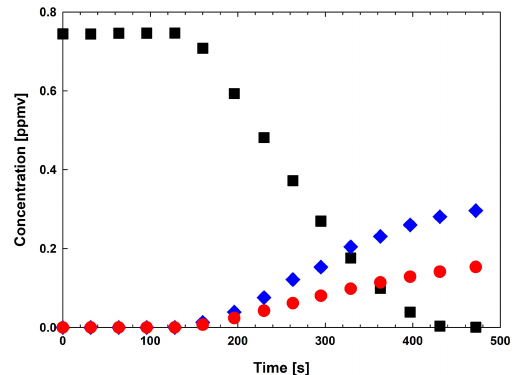
Figure 6. Concentration–time profiles for the reaction of MMPO ( ) + OH radicals and the quantified product of methyl formate ( MF) and peroxypropionyl nitrate (